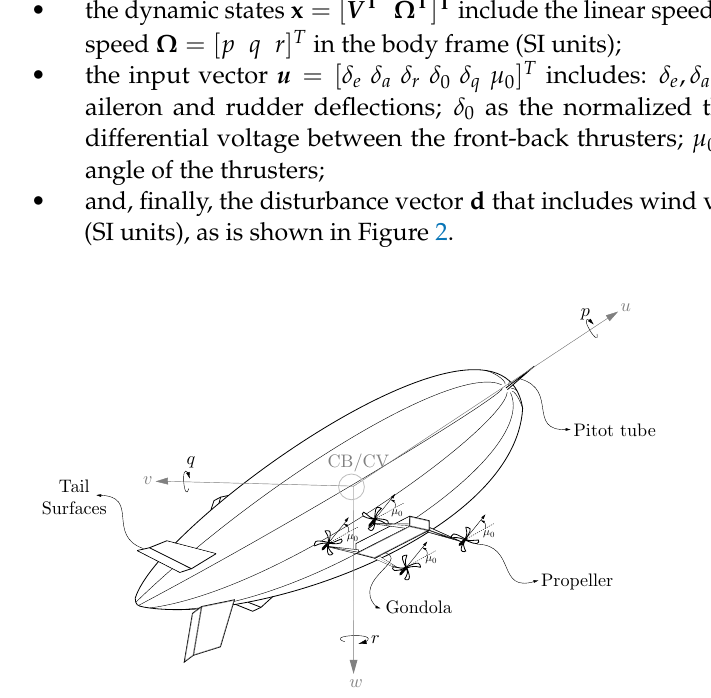
Figure 2. NOAMAY airship body